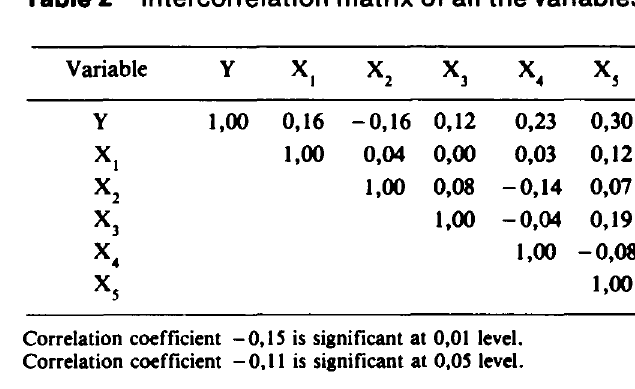
variables under examination. lntercorrelation matrix of all the